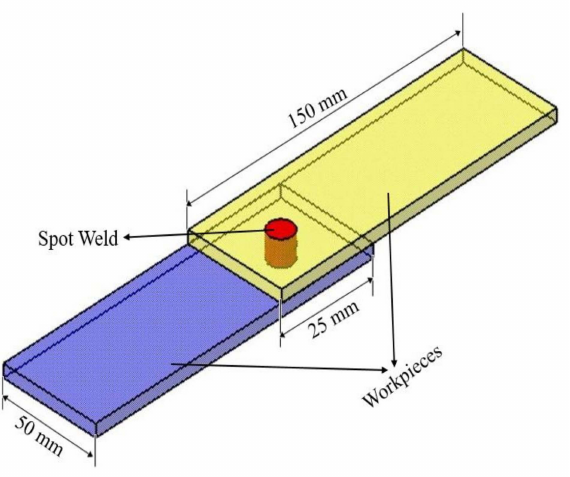
Figure 2. Lab shear joint configuration of similar AA7075-T6